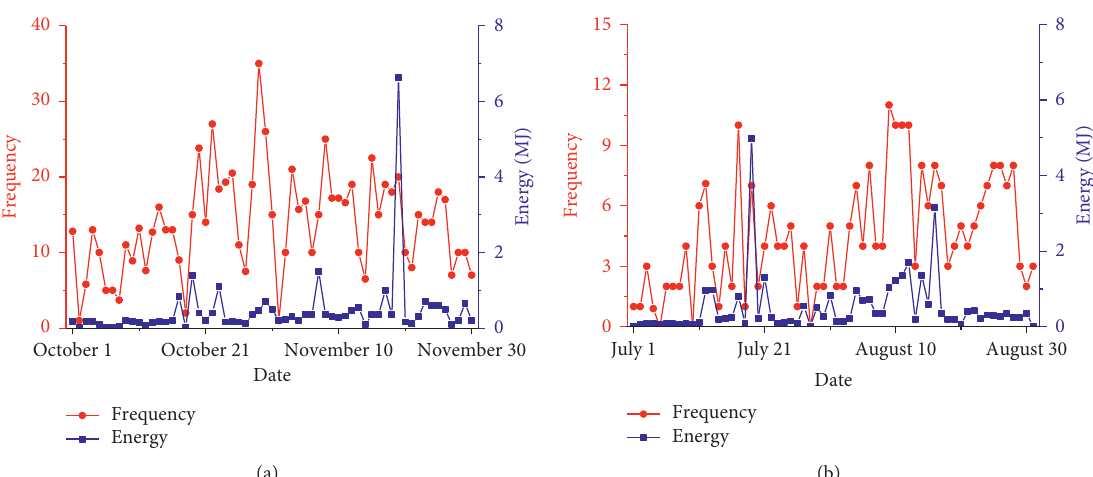
Figure 11: Microseismic monitoring results during mining. (a) No. 1411 working face without advanced pressure relief. (b) No. 1412 working face with advanced pressure